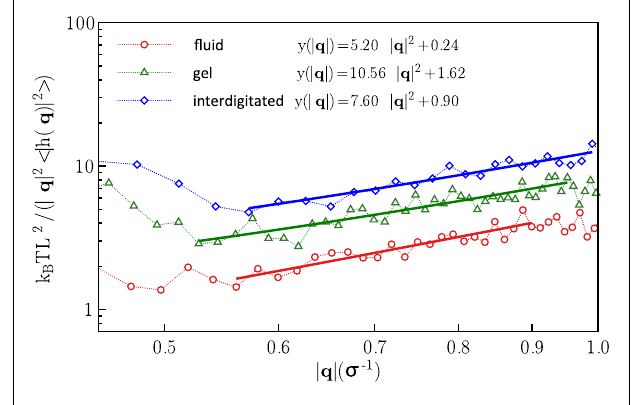
FIGURE 5 | Fluctuation spectra for the fluid, gel, and interdigitated phases and fits to the Eq. (5) .